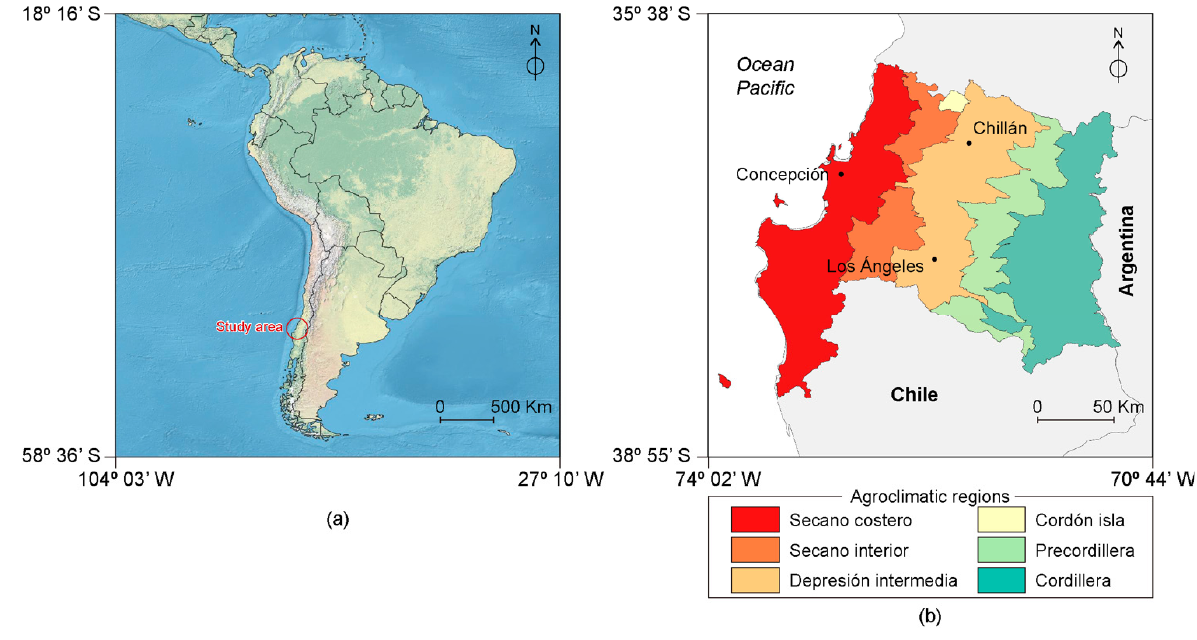
Figure 1. Study area: ( a ) general context and ( b ) agro-climatic regions in Biobio